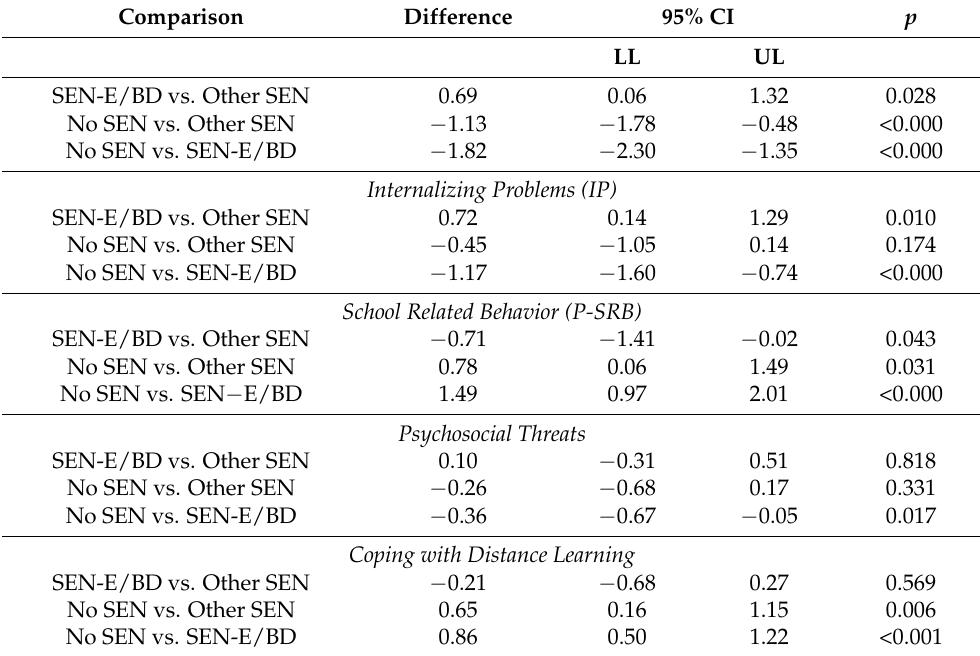
Table 5. Pairwise comparisons from